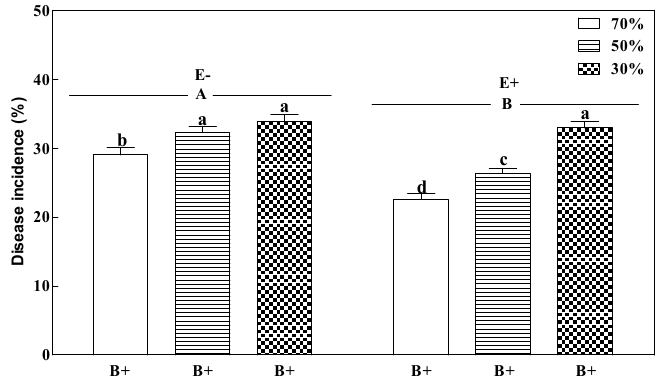
Figure 1. Disease incidence of perennial ryegrass infected with (E+) or without (E − ) fungal endophyte at 70%, 50%, and 30% soil water regimes at harvest. Mean ± SEM of four replicates are shown. Bars topped by the same lowercase letter indicate no significant difference between soil water regimes and pathogen within fungal endophyte treatments at p ≤ 0.05 by Tukey’s honestly significant difference (HSD) test. Bars topped by the same uppercase letter indicate no significant difference associated with the fungal endophyte at p ≤ 0.05 by Tukey’s HSD test.